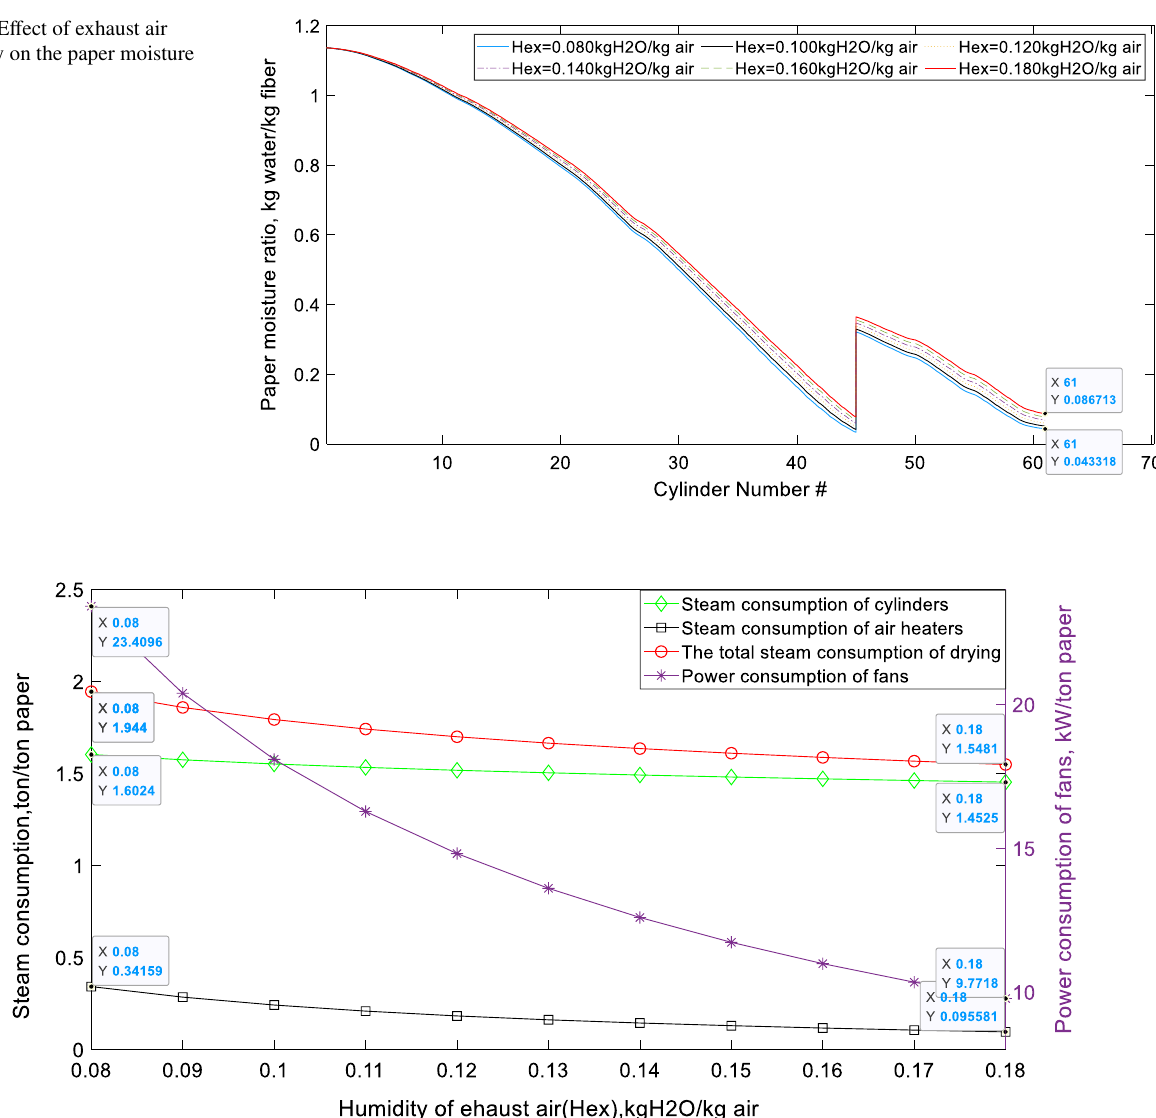
Fig. 12 Effect of exhaust air humidity on the energy consumption of drying